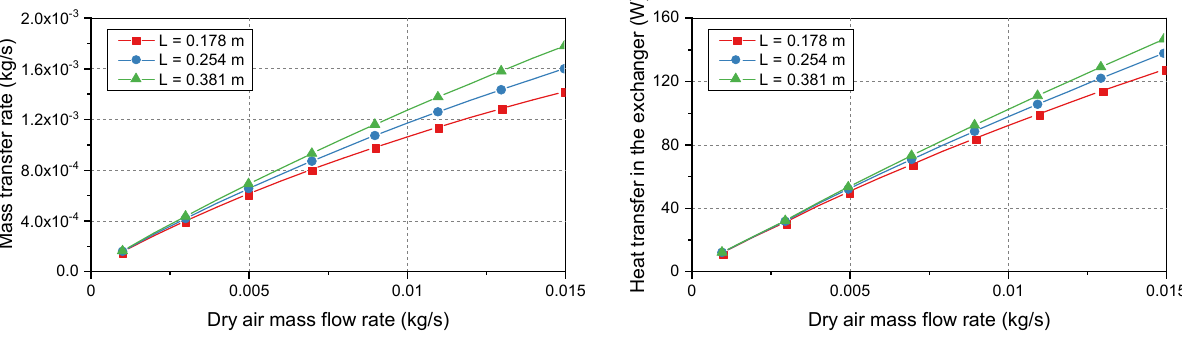
Figure 5. Effects of the membrane length on the humidifier performance. The membrane thickness is an important factor for its manufacture. The bundle requires a sufficient membrane thickness to support the structure. However, a thinner membrane allows for a higher mass transfer rate. Figure 6 illustrates the effects of the membrane thickness on the heat and mass transfers. As the thickness increased, the mass resistance of the membranes became more significant, which prevented the movement of vapor particles between membrane surfaces. Increasing the thickness from 0.05 mm to 0.15 mm decreased the mass transfer rate by 15%. In contrast, the heat transfer rate was less affected by the membrane thickness. The membrane thickness directly affects heat conduction. However, the convective heat transfer dominates transport phenomena, which makes the heat transfer rate less dependent on the thickness.